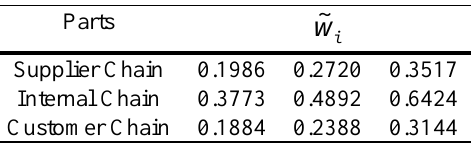
Table 7. Fuzzy weights of each part.